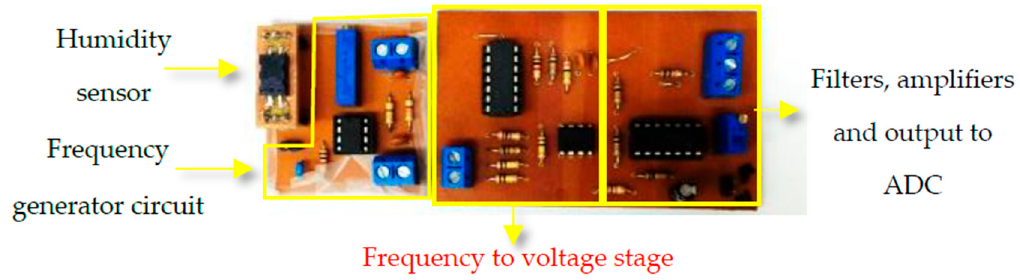
Figure 6. Signal processing scheme to register humidity fluctuations on an embedded system. Source: Authors. Data acquisition starts with an optical synchronization, as shown in Figure 3. Cameras and sensors are set up before the laser beam port is opened. Thus, each subsystem is operating in an isolated manner under the frozen turbulence hypothesis [24]. Timers are programmed to acquire 1800 samples at a sampling frequency of 1 Hz. The number of samples considers the evaluation of humidity stability, calculation of the average time in turbulence parameter, and the sampling frequency to warrant synchronized acquisition over all devices (cameras, PCs, and micro-controller). 3. Results Several experimental scenarios with controlled relative humidity were designed in order to evaluate the effects of relative humidity in the turbulence parameters. Some air temperature measurements are also summarized in Table 2 however, they were only references because the changes made in humidity lead to few changes in air temperature. Table 2. Tests designed. Source: Authors. Test Name Relative Humidity (RH) Average (%)